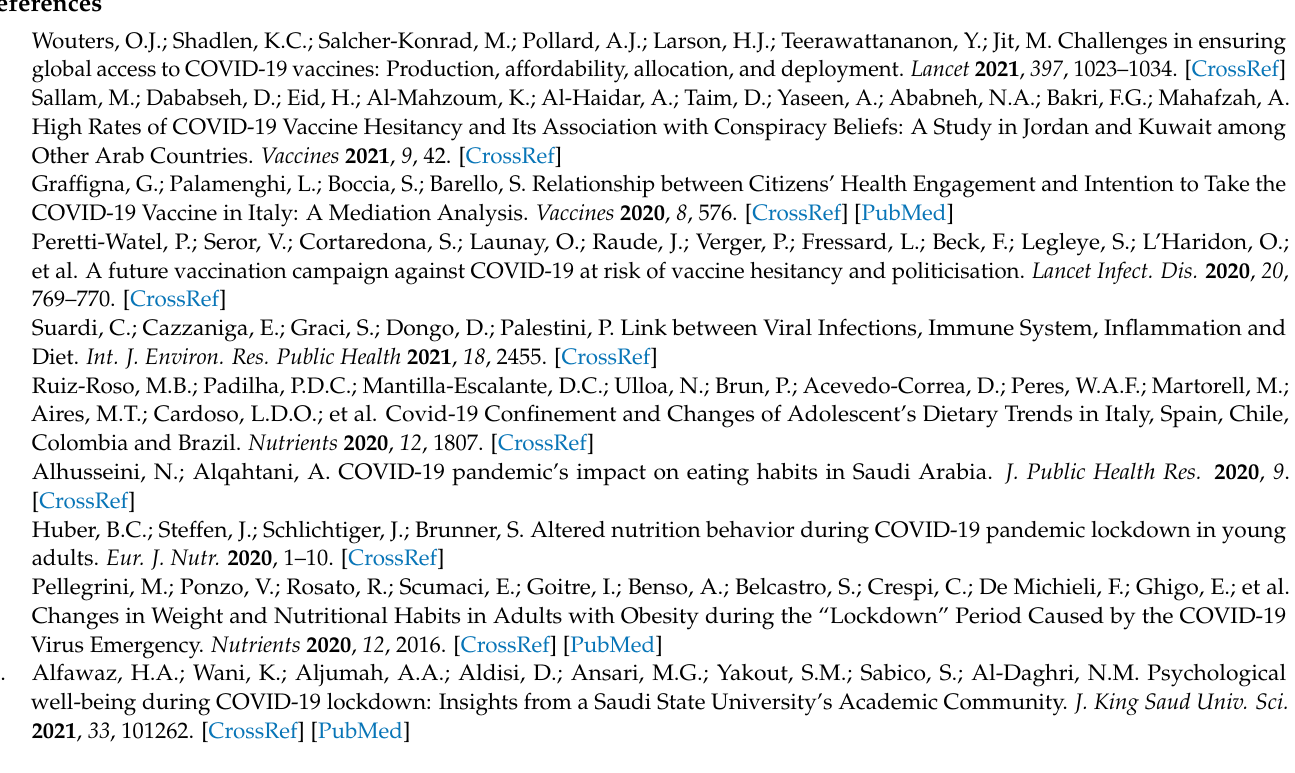
and family members. Table S2: Percentage of supplement use according to COVID-19 status. Table S3: Gender distribution among participants for Supplementation use according to Education, Income, and Age. Table S4: Dietary Supplement use based on nationality and